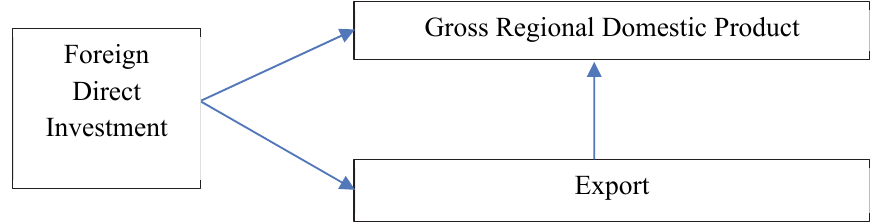
Fig. 2. Generalized model from research